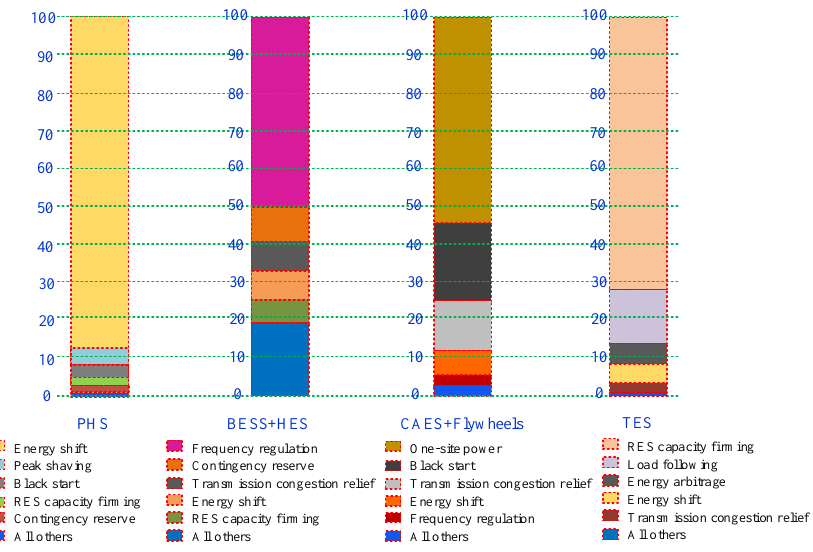
Figure 15. The global capacity of power shares by type and application of ESS by the end of 2021 ( data come from previously conducted research [102,103]). Table 2. Recent HESS application in renewable energy generation